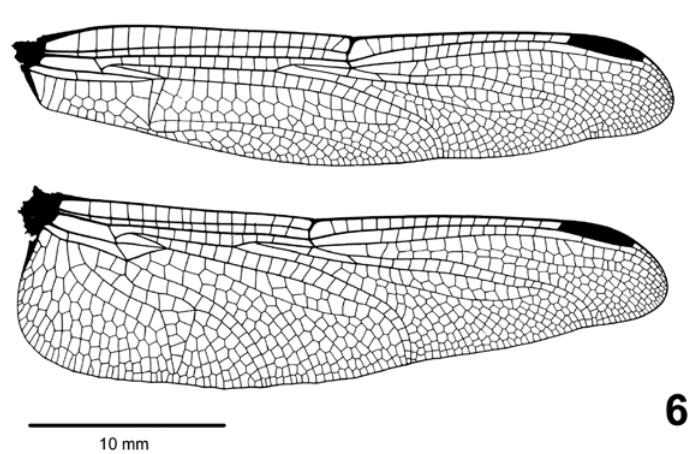
Fig. 6 - Carajathemis simone n. gen., n. sp. male paratype,